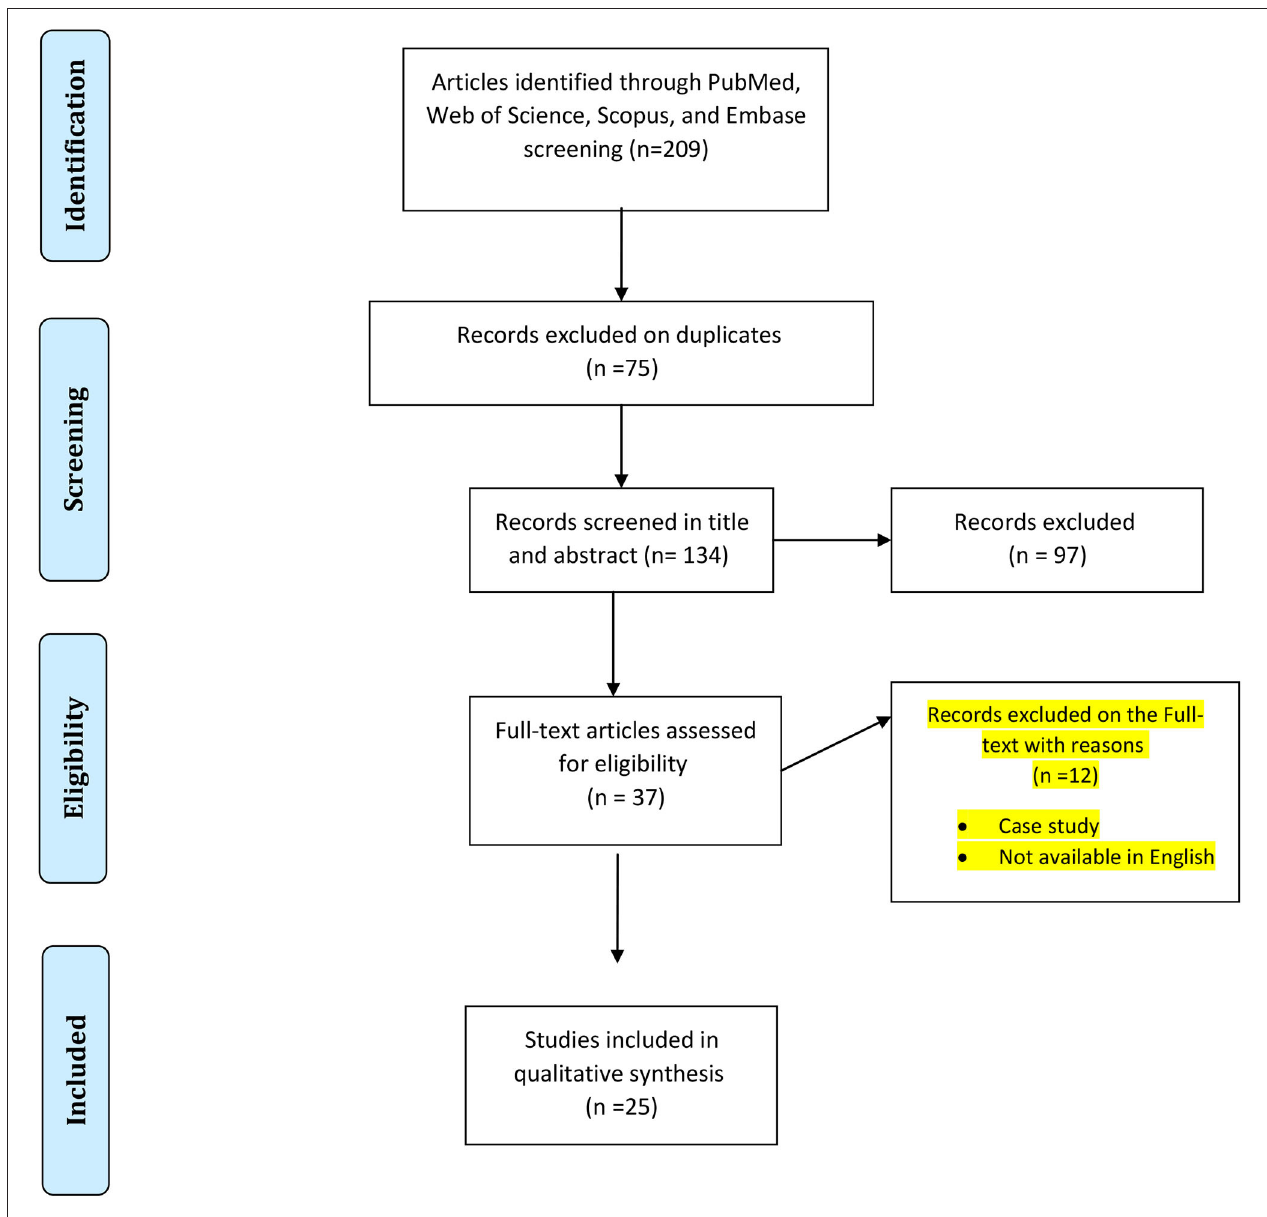
FIGURE 1 | PRISMA flowchart showing the search and study selection